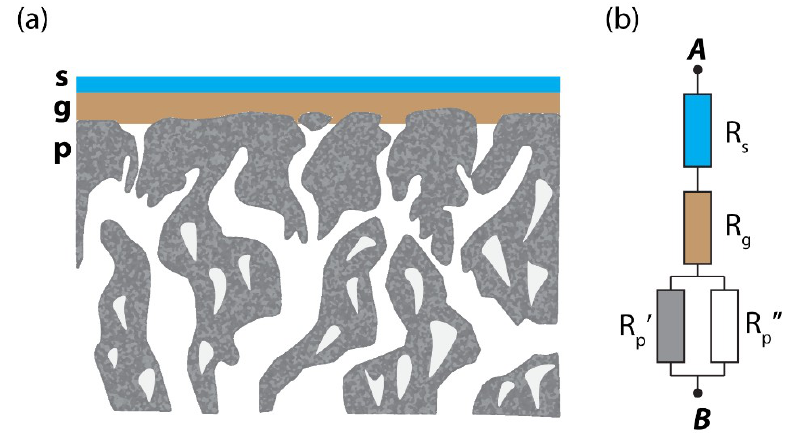
Figure 3. ( a ) General structure of TFC membranes investigated in this work consisting of three layers: s —selective (Pebax-1657), g —gutter (PDMS), and p —porous support layer. ( b ) Electrical circuit analog of the tri-layer structure.